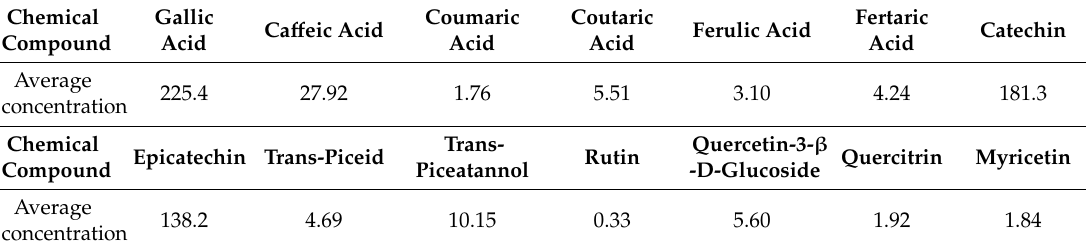
Table 2. Average concentration of analyzed compounds in 2015. The results are expressed in µ g / g of dry matter.